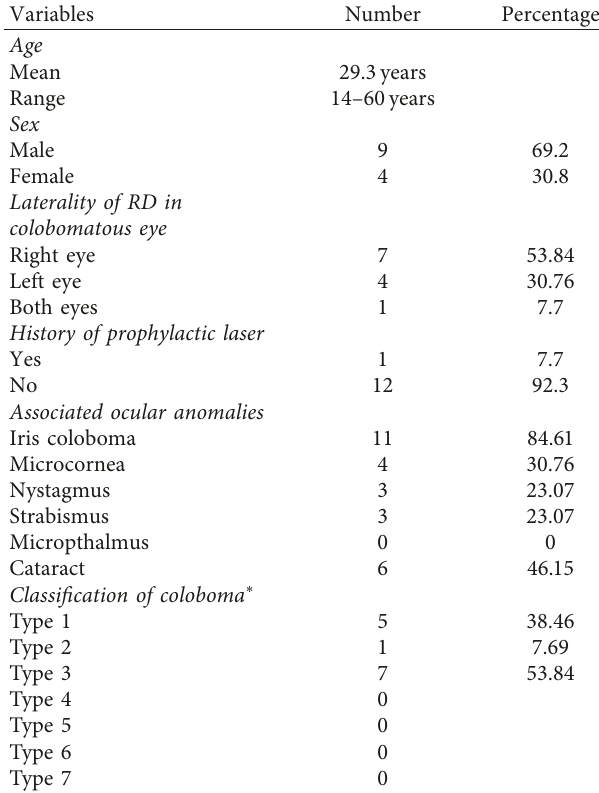
Table 1: Patient characteristics ( N � 13).